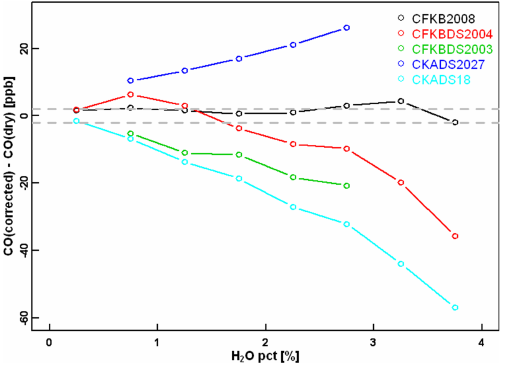
Fig. 7. Differences of corrected wet measurements using the coefficients ( A =16.628% − 1 , B =12.460% − 2 , C = − 10.692% − 3 , D =1.275% − 4 ) derived in Sect. 2 for CFKBDS2007 and dry values for water tests on each analyzer. Dashed lines indicate the compati- bility goals set by the WMO for CO measurements.